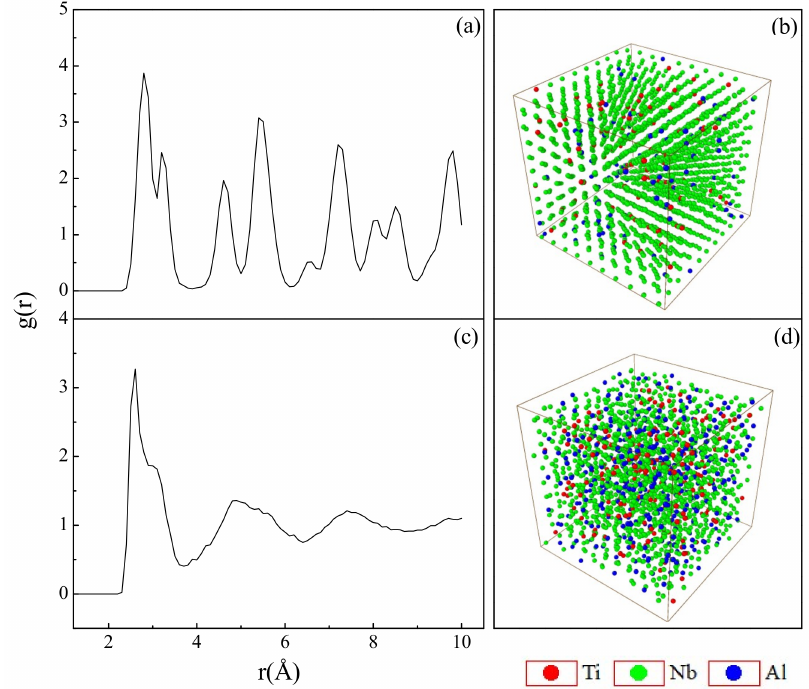
Figure 2. The g ( r ) and 3D atomic position projections for ( a , b ) Ti 5 Nb 90 Al 5 (crystalline state) and ( c , d ) Ti 10 Nb 70 Al 20 (amorphous state),